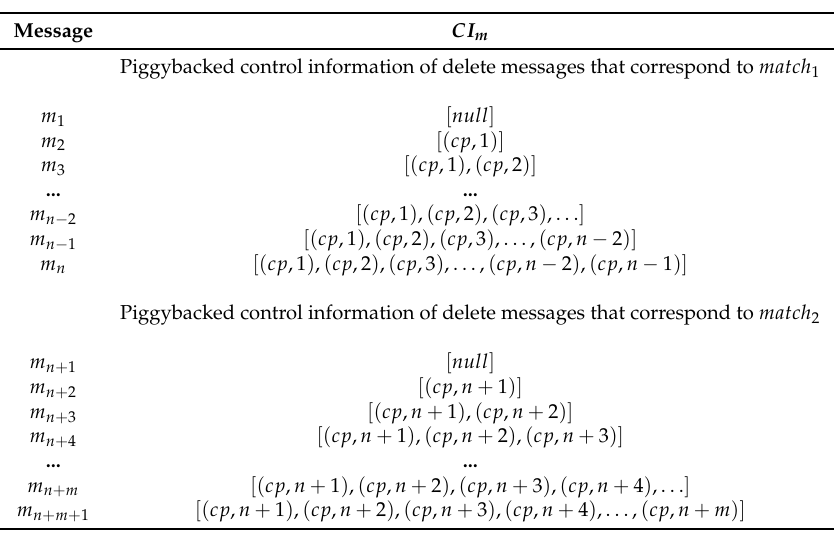
Table A1. Piggybacked control information corresponding to update messages of match 1 and match 2